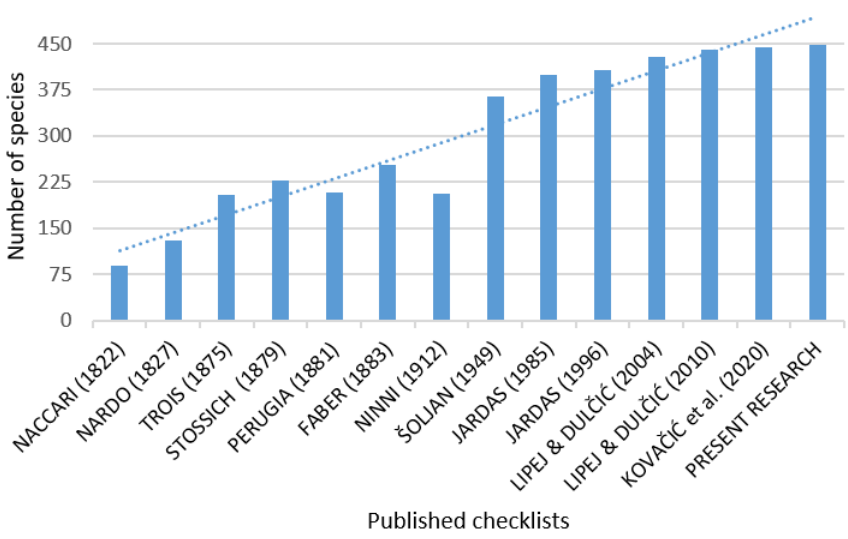
Figure 2. Number of Adriatic fish species according to various checklists of Adriatic fish and current